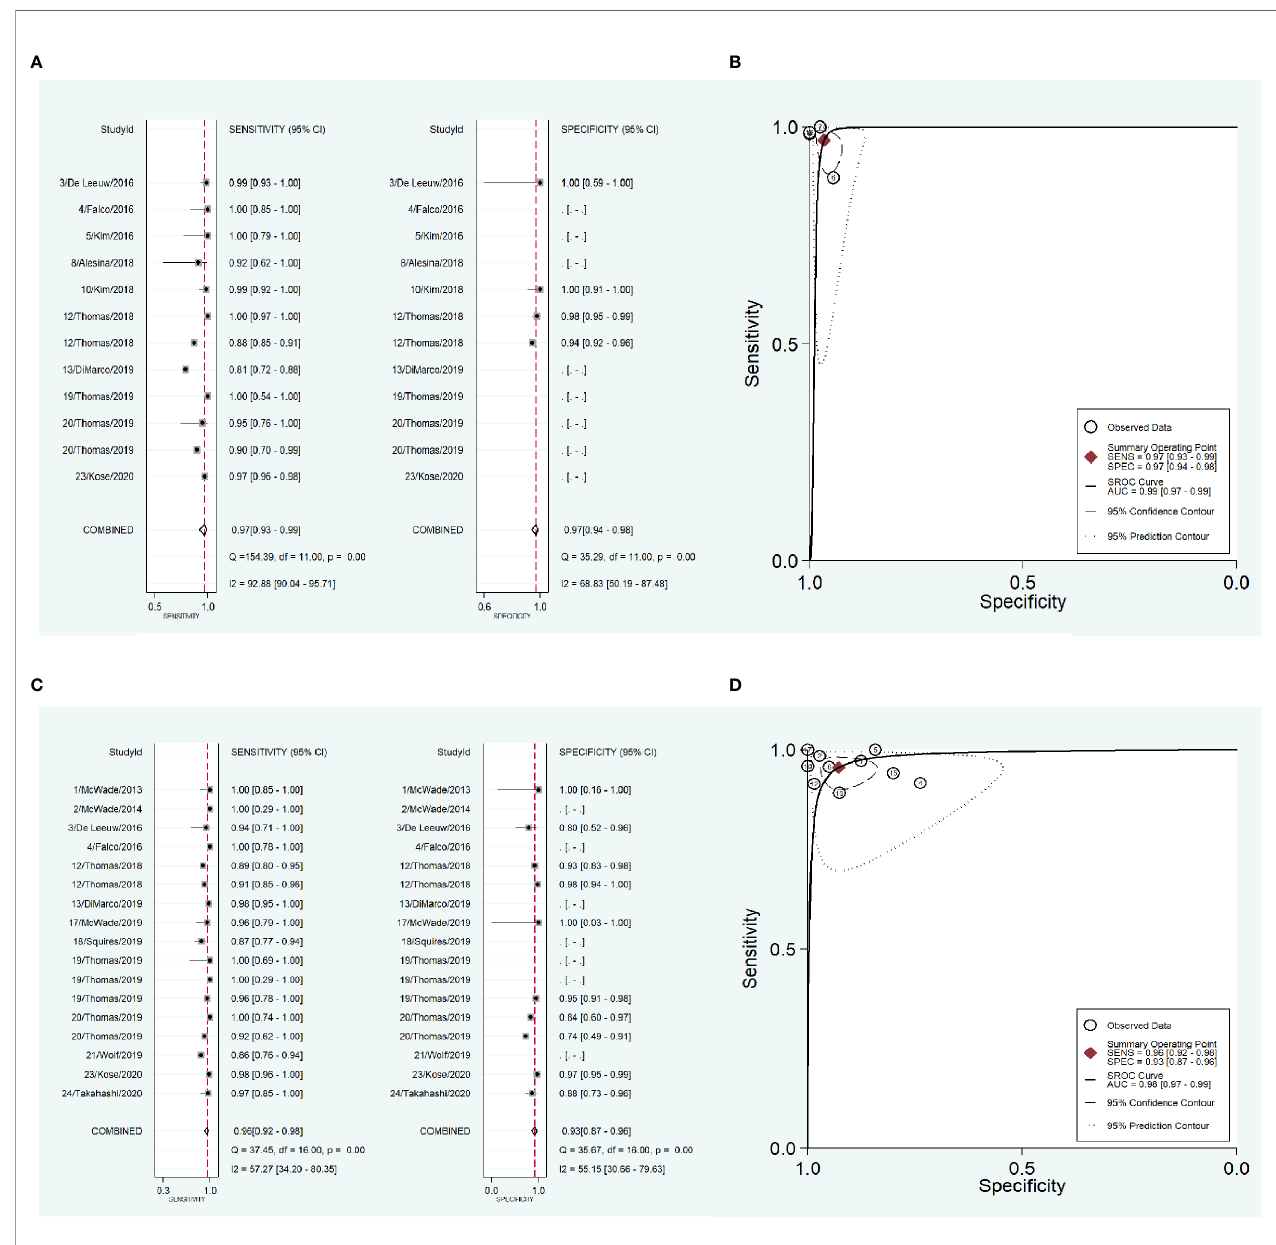
FIGURE 6 | The accuracy of near infrared auto fl uorescence in the subgroup analysis of the reference standard of the diagnosis of parathyroid gland. (A) forest plot of the studies in the subgroup of experience. (B) summary receiver operating characteristic (SROC) curve in the subgroup of experience. (C) forest plot of the studies in the subgroup of pathology report. (D) summary receiver operating characteristic (SROC) curve in the subgroup of pathology report.